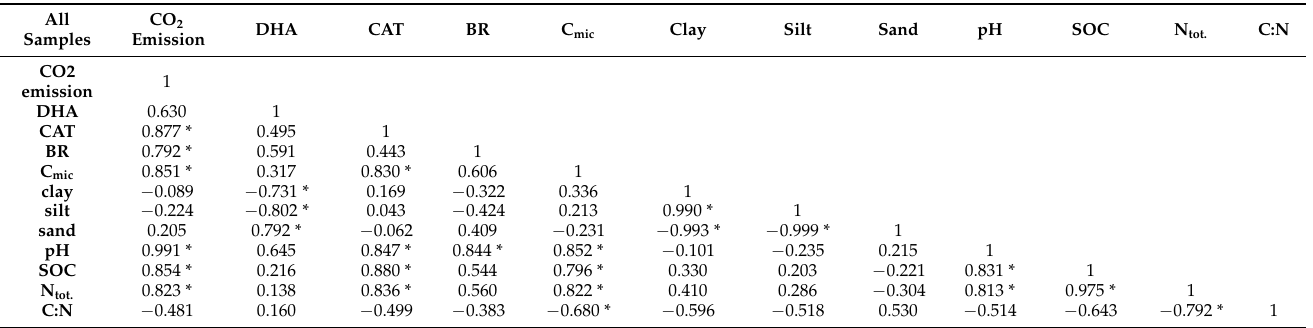
Table A1. Correlation coefficients between the CO 2 emission and the microbial and physicochemical parameters of soils from the top, mid-slope, and bottom of the forest gully (asterisk indicates significant differences at p < 0.05). All CO 2 Samples Emission DHA CAT BR C mic Clay Silt Sand pH SOC N tot.